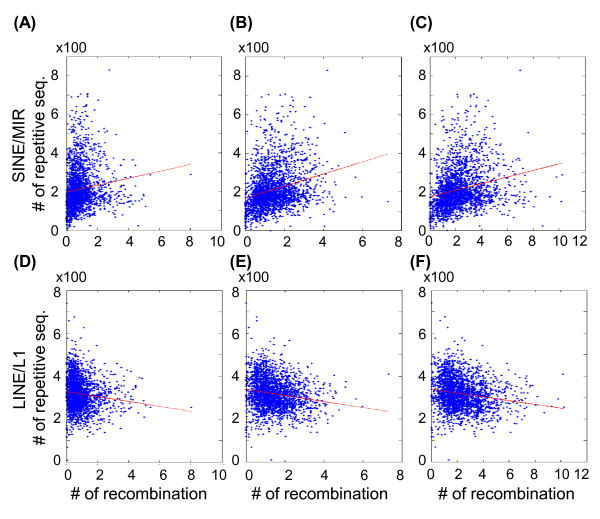
Scatter plot of the number of paternal (A, D), maternal (B, E), and sex-averaged (C, F) recombination sites for the SINE/MIR (A, B, C) and LINE/L1 (D, E, F) repetitive sequences on chromosome 1. Regression lines are marked in red.